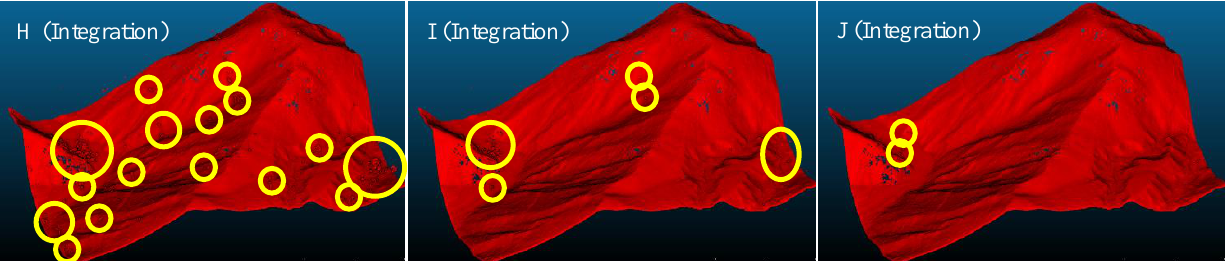
Figure 8. Resulting ground surface by integration of multiple network